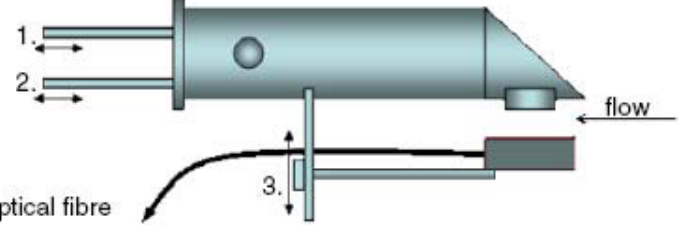
Figure 10. Sketch of the submersible imaging system [102]. 1, 2 and 3 in the figure are three rods to easily adjust the camera position, objective magnification and light diffuser position. The diode laser light is guided through an optical fibre to a back-light diffuser. The imaging system is controlled with a laptop computer and a programmable timing